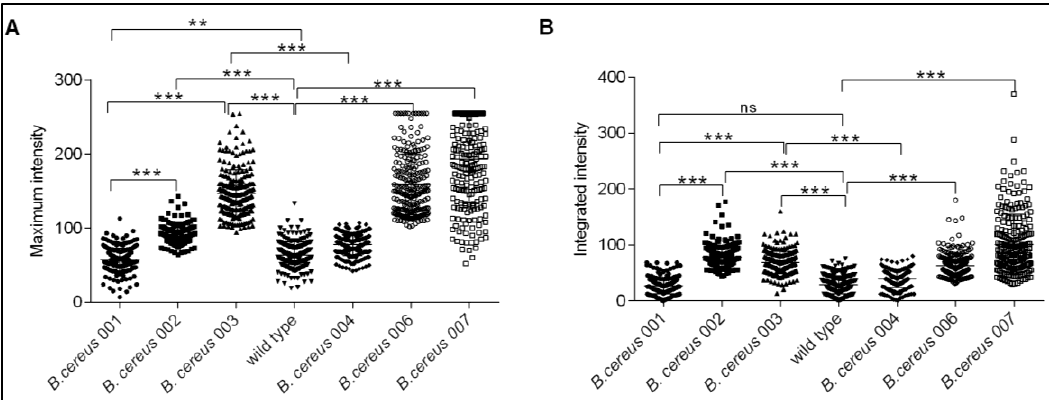
Figure 3. Analysis of the fluorescence intensity and calculations of fluorescence in individual B. cereus spores of strains numbered as in Table 1. ( A ) Maximum fluorescence intensity in dormant spores of various strains; ( B ) Integrated fluorescence intensity in dormant spores of various strains. ns: not significant, **: p < 0.01 and ***: p < 0.001. Note that in figure A the apparent dark bar at the top of the data for strain B. cereus 007 reflects a large number of overlapping individual points.